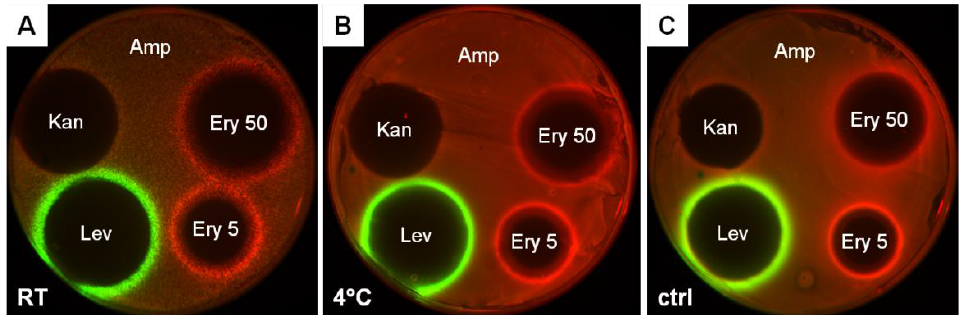
Figure 3. Comparison of fluorescence induction after the freeze-dried cells were kept for 8.5 months (257 days) at room temperature ( A ), at 4 °C ( B ) and overnight culture as a control ( C ). Agar plates were coated with the E. coli Δ tolC strain transformed with the pDualrep2 plasmid and spotted with antibiotics at the following concentrations: ampicillin (Amp, 100 mg/mL), erythromycin at two concentrations (Ery 50, 50 mg/mL, and Ery 5, 5 mg/mL), levofloxacin (Lev, 25 µg/mL) and kanamycin (Kan, 50 mg/mL). The plates were scanned in Cy3 (TurboRFP) and Cy5 (Katushka2S) channels, shown as green and red pseudocolors, respectively.